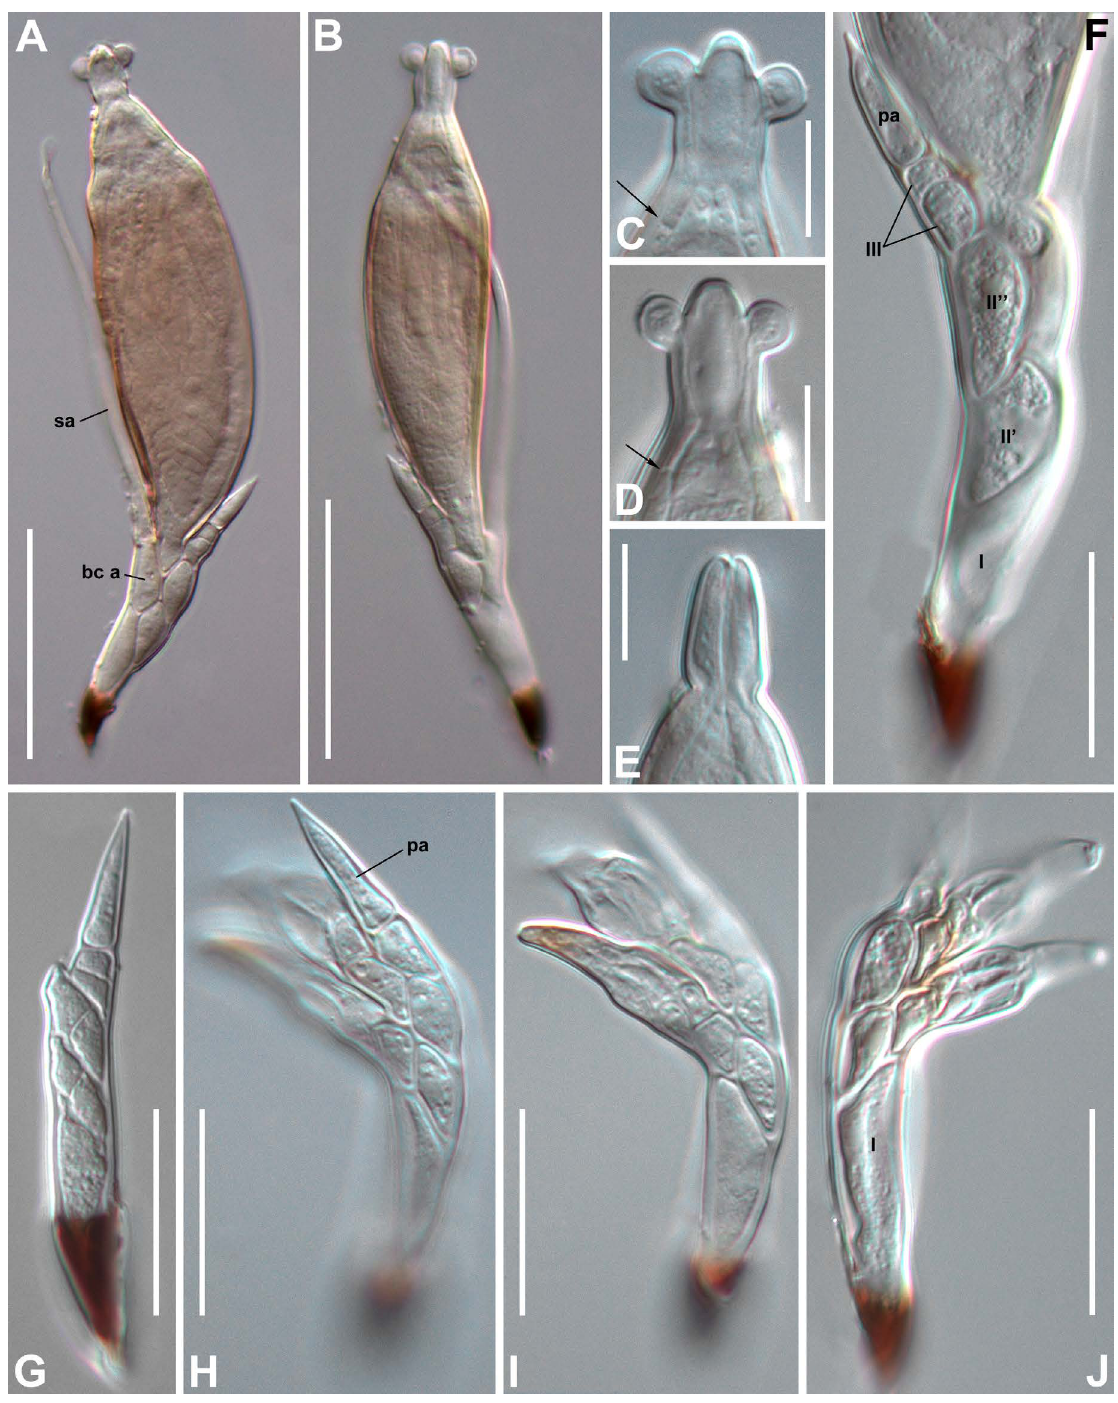
Fig. 72. Dimeromyces oculatus Santam. sp. nov. A – B . Mature female thalli with labelling of secondary appendage (sa) and its basal cell (bc a) in A. C – E . Perithecial apex in detail, frontal view in C–D and side view in E; arrows point to septum separating the two distal wall cells. F . Lower area of a mature female thallus in detail focusing on certain cells, viz., primary appendage (pa), III, II’, II”, and I. G . Young male thallus. H – J . Male thalli at different focus levels, with primary appendage labelled in H. Scale bars: A–B = 50 µm; C–E = 10 µm; F–J = 20 µm. Photographs from slides ZMUC C-F-123800 (A–E) (isotype), ZMUC C-F-123799 (F–J)